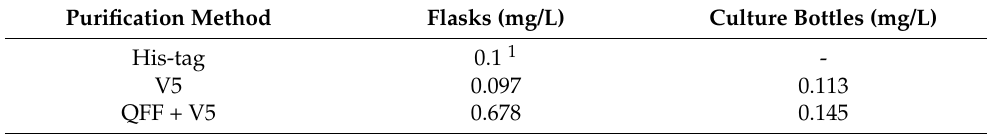
Table 1. rADAMTS13 yields purified from flasks and culture bottles via V5 or QFF + V5. Purification